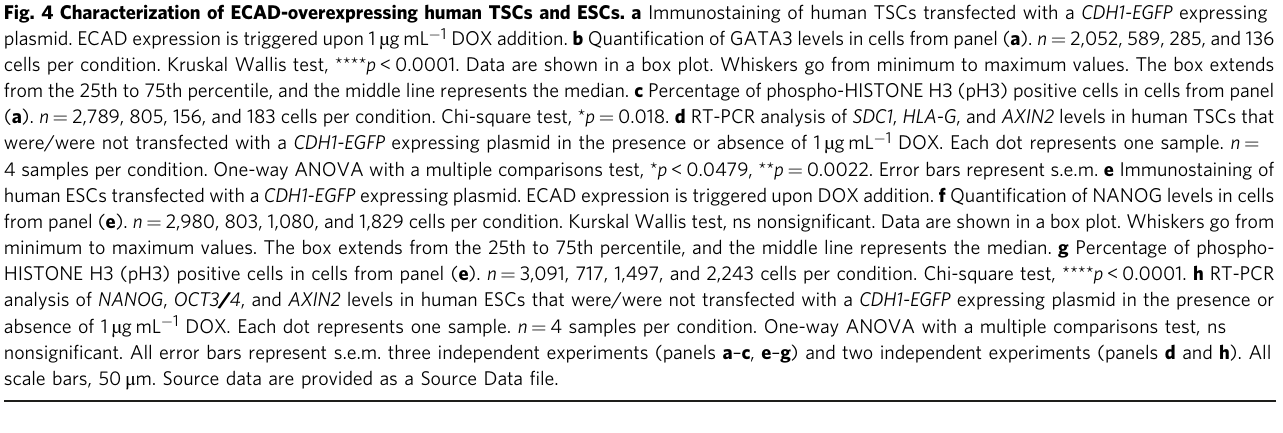
scale bars, 50 μ m. Source data are provided as a Source Data